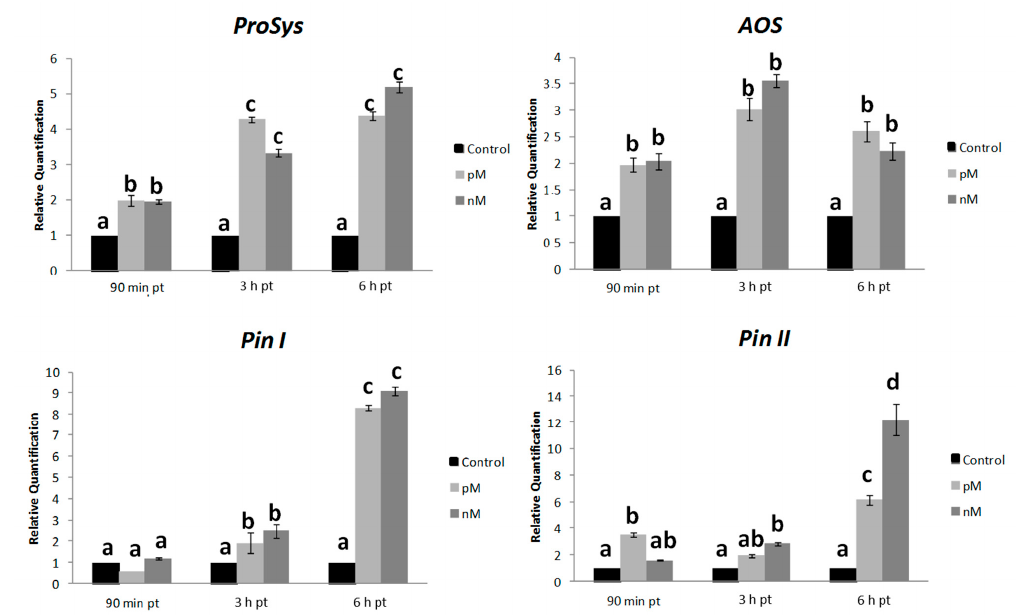
Figure 7. Gene expression analysis in leaf treated with Sys (local). Quantification of transcripts of early ( ProSys, AOS ) and late genes ( Pin I, Pin II ) by Reverse-Transcription-Polymerase Chain Reaction (RT-PCR) after 90 min, 3 h and 6 h following 100 pM and 100 nM systemin peptide treatment. Relative quantities are calibrated on samples obtained from tomato leaves spotted with PBS1X (Control). For each gene, relative quantification ( RQ ) variations have been analysed by two-way ANOVA. Different letters denote significantly different values ( p < 0.01). Error bars indicate standard error.